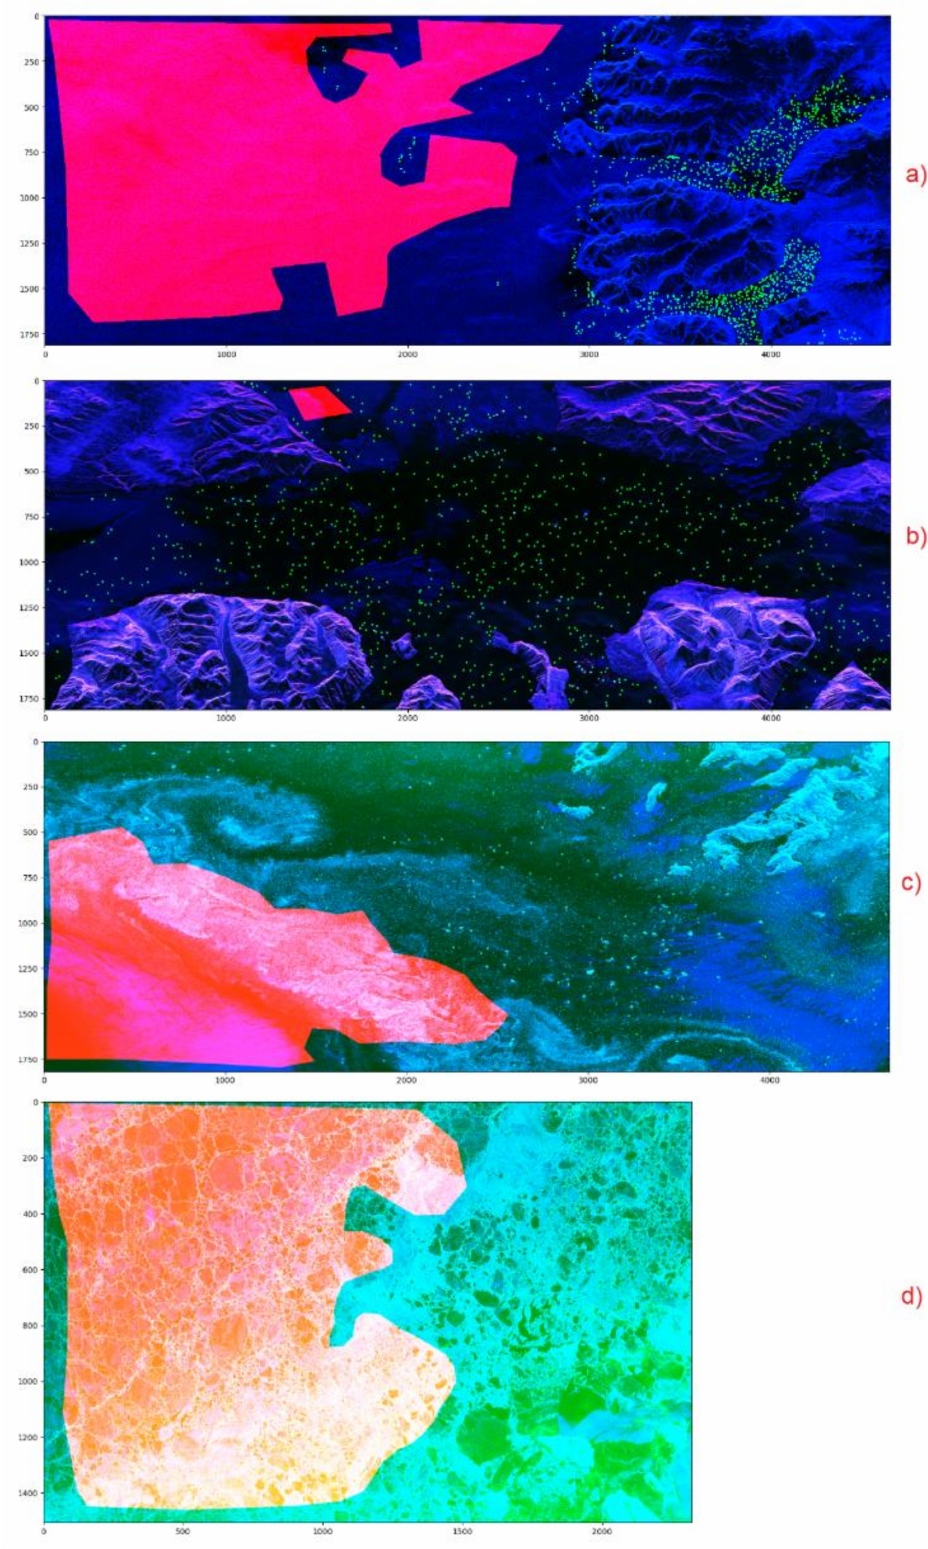
Figure 6. Pauli images of each location. ( a ) Target and clutter mask for Blosseville. Scenario is a mix of open ocean, and glacier tongues. Azimuth ambiguities are present in the middle of the image. ( b ) Nuugaatsiaq. Scenario is a mix of open ocean, and islands. ( c ) Isortoq. Scenario is a mix of sea ice and ice floes. Note blue dots for icebergs. ( d ) Savissivik. Scenario is mainly sea ice, with embedded targets, and green areas indicate icebergs. Red polygons indicate